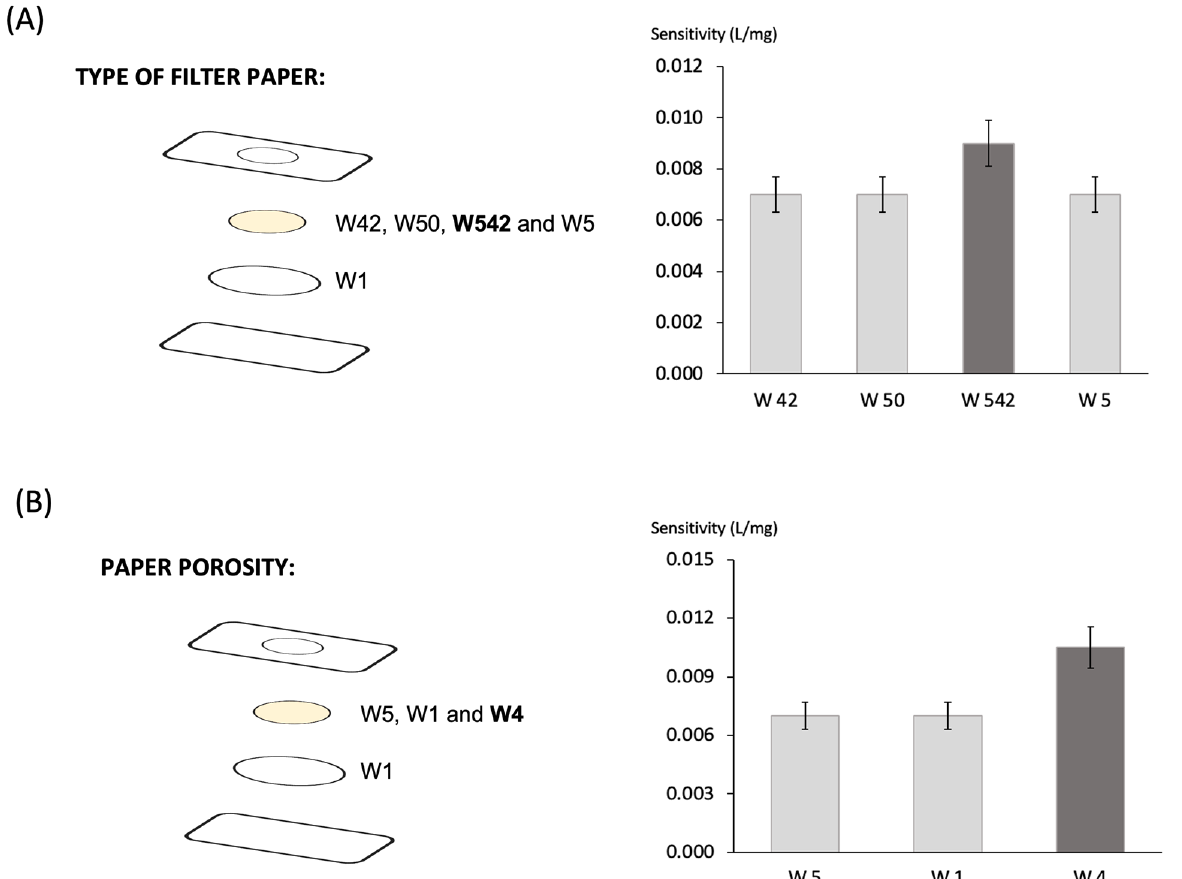
Figure 3. Study of the influence of different filter papers (Whatman filter paper: Wi) in the calibration curve slope; ( A ) papers with different treatments; ( B ) papers with different porosities; the dark grey bars represent the chosen option; the error bars represent 10% deviation of the measurements.